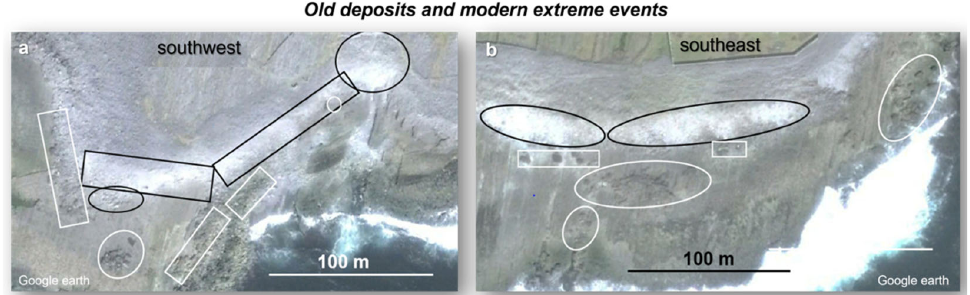
Figure 9. South coast of Inisheer after the hurricane storms of winter 2013/2014, the strongest storms on registration and in living memory, at highest postglacial sea level. Black frames mark activation (mostly erosion) at the seaward ridge slope; white frames mark boulder clusters remaining immobile, although in full storm wave attacks. All elevations shown are below +10 m mhw (compare with Figure 10). ( a )—southwest exposure; ( b )—southeast exposure.